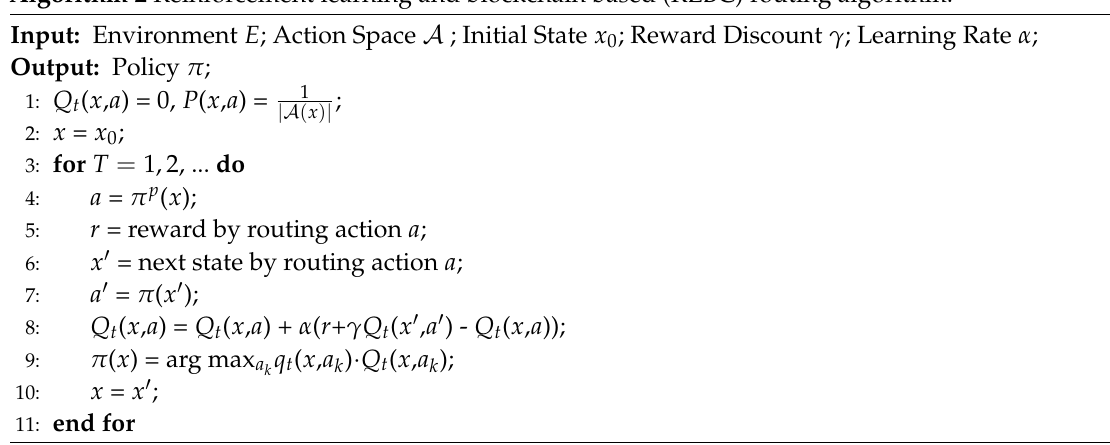
Algorithm 2 Reinforcement learning and blockchain based (RLBC) routing